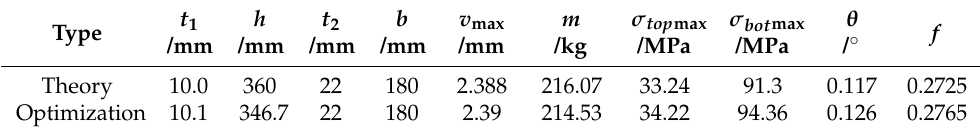
Table 2. Optimized results of mass in single beam.